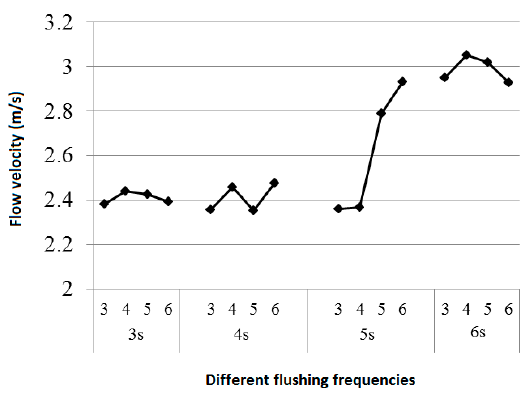
Figure 23. Flow velocity comparison of all the frequencies when the slot nozzle is set in the middle of the pipe.